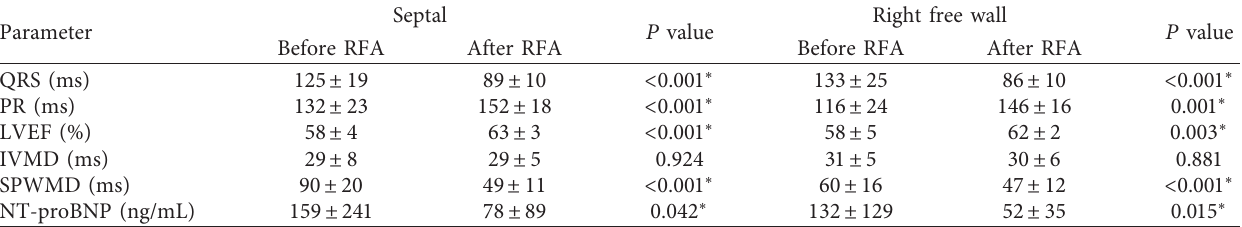
Table 4: Comparison of measurements in patients with septal and right free wall accessory pathways before and after ablation.